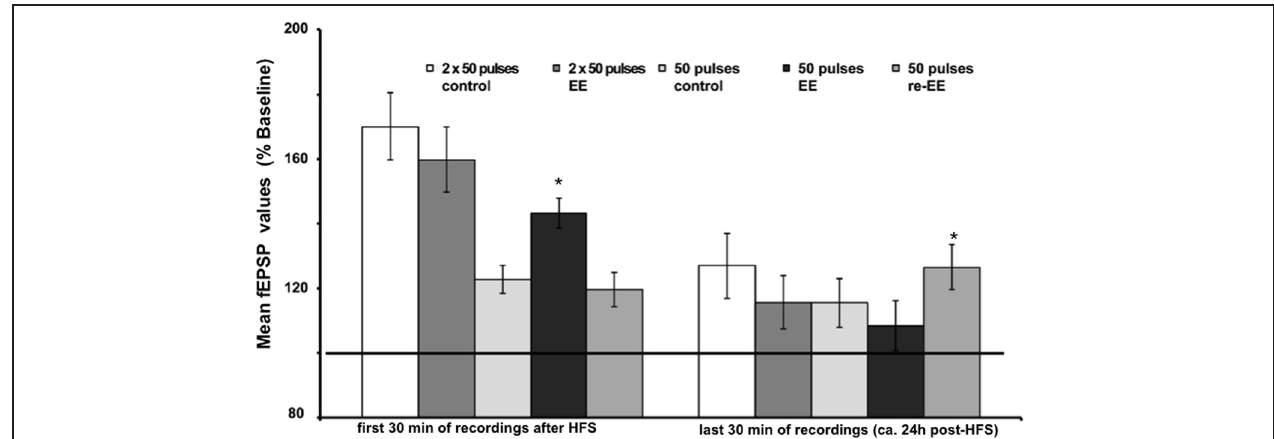
with the weaker protocol (1 × 50 pulses) is no longer present 24h after HFS in controls. However, the initial 14 day exposure to EE (1st EE) enhances the magnitude of the first 30min of E-LTP. Re-exposure to EE (2nd EE) 6 weeks after 1st EE results in a significant prolongation of late (L-)LTP in EE-treated mice compared to controls that is evident 24h after HFS. The reference baseline is represented by a black bar (100%). Asterisk denotes significant effect.